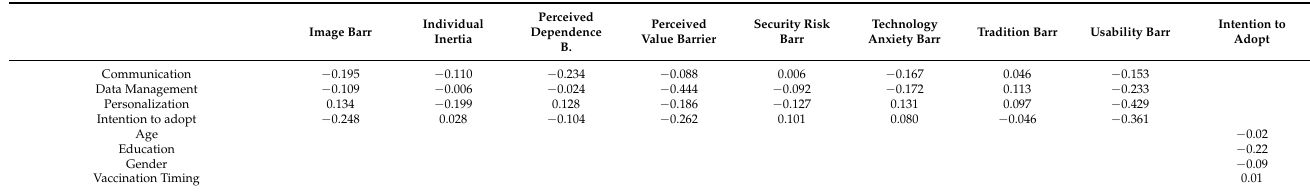
Table 2. Results from Structural Equation Modeling.